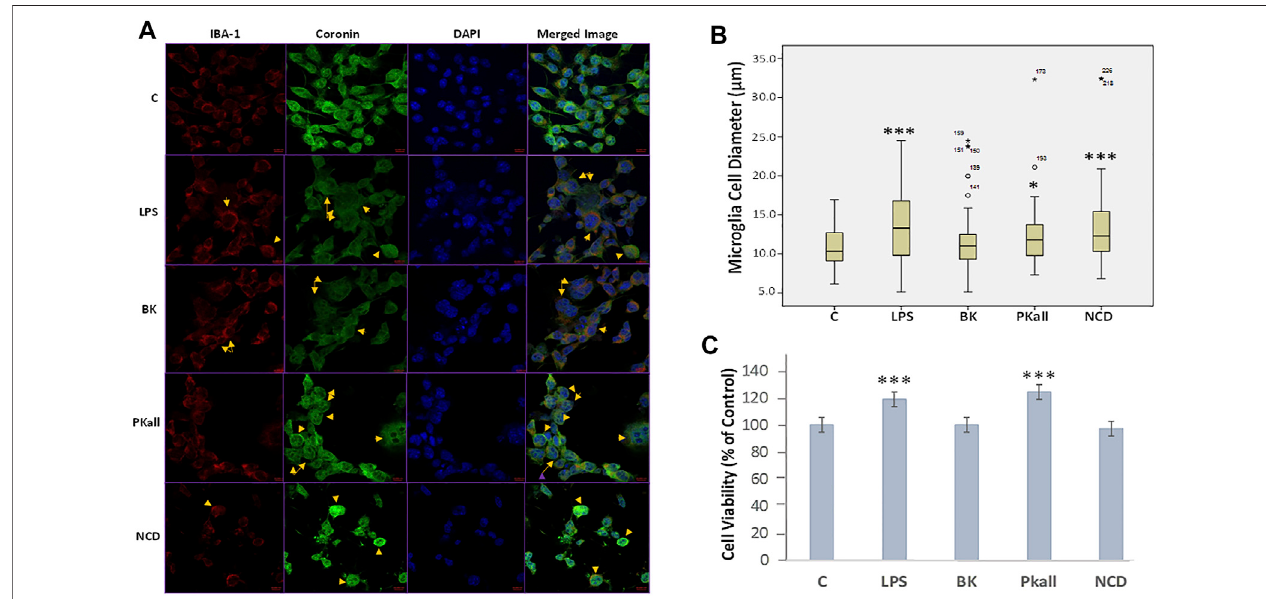
FIGURE 2 | Immuno fl uorescence and morphological changes of activated microglial cells. N9 microglial cells cultured on coverslips were stimulated with vehicle control (c), LPS (100 ng/ml), BK (0.1 µM), PKall (2.5 ng/ml), and NCD (16.5 µg protein/ml) for 24 h (A) Immunostaining was conducted using a speci fi c anti-IBA-1 antibody(red),anti-Coroninantibody(green),DAPItorecognizethenucleus (blue),andthemerged image. Theyellowarrowsindicateachangeinthemorphologyofthe microglial cells adopting a more rounded amoeboid shape indicative of phagocytosis. The immuno fl uorescence intensity of IBA-1 and coronin was not different between the groups. (B) Boxplot demonstrating the changes in microglial cell diameter (µm) in response to LPS, PKall, BK. and NCD stimulation measured by confocal microscopy.Dataarerepresentativeofatleast50cellsfromdifferentrepresentativeimagesandexpressedasmean ± SE(* p ≤ 0.03,*** p ≤ 0.001vsC). (C) Cellviabilityof microglial cells. Microglial cell viability was determined by MTT assay in response to LPS, BK, PKall, and NCD. The bar graph represents the microglial cell viability expressed as a percentage of control (*** p ≤ 0.001, LPS or PKall vs. C, respectively, n (cid:1) 12).